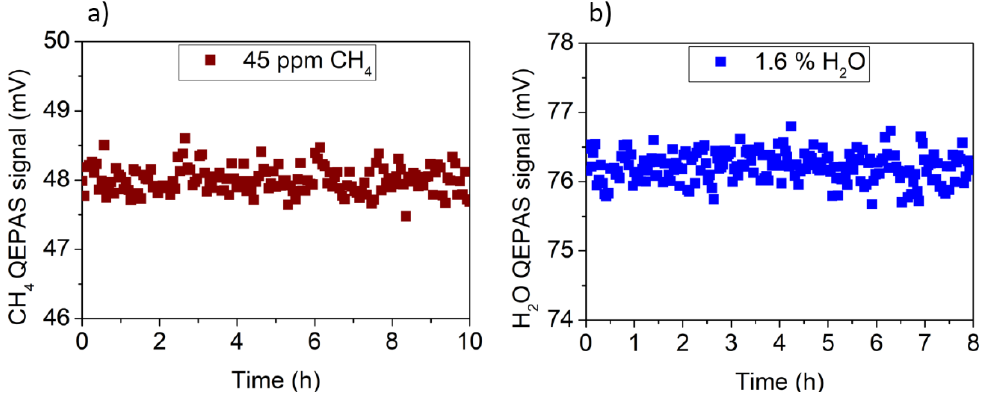
Figure 4. ( a ) Methane QEPAS peak signal as a function of time when a gas mixture of 45 ppm of dry CH 4 in N 2 was flowing in the sensor; ( b ) H 2 O QEPAS peak signal as a function of time when water concentration in the gas line was fixed to 1.6% using a PermSelect